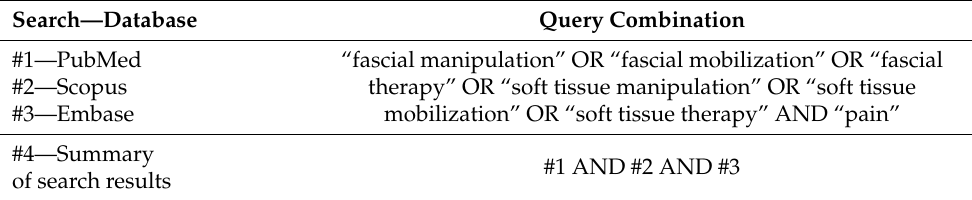
Table 2. Summary of search strategies in PubMed, Scopus and Embase